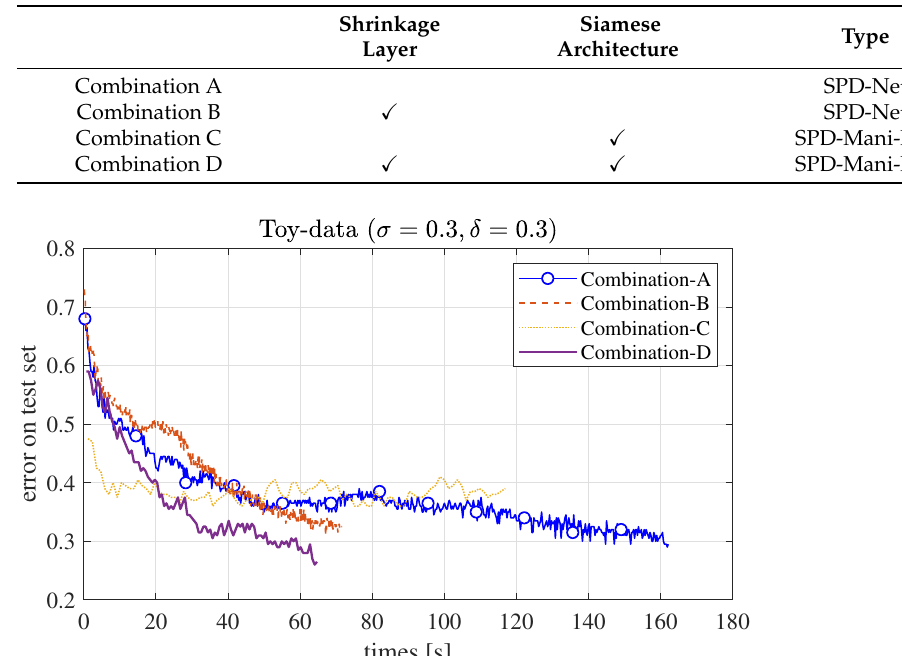
Table 2. The configuration of combinations.